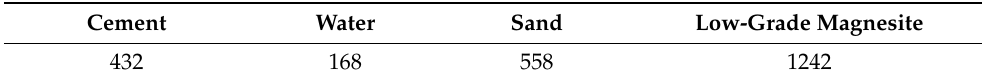
Table 3. Mix proportion of concrete (kg/m 3 ).